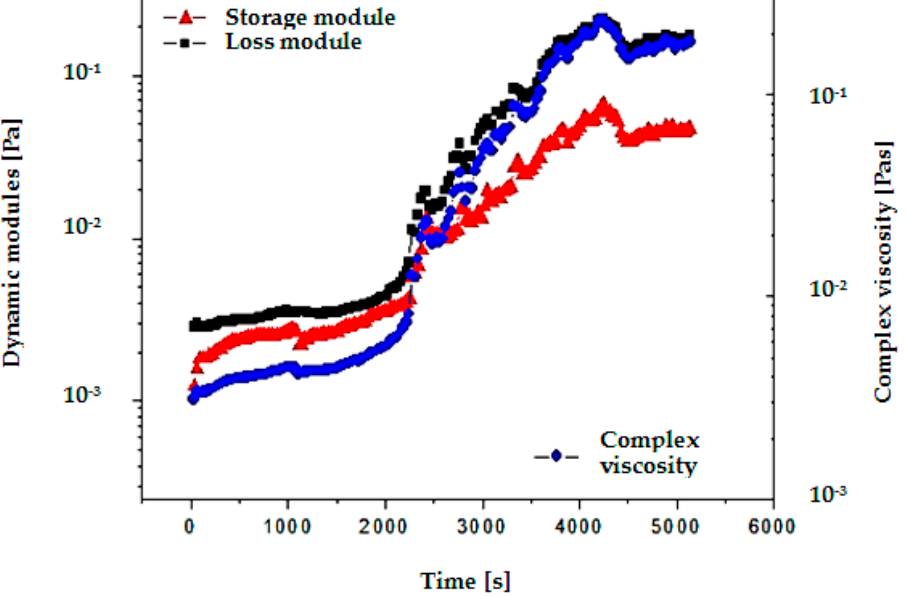
Figure 9. Storage module, loss module and complex viscosity for EM_4a.